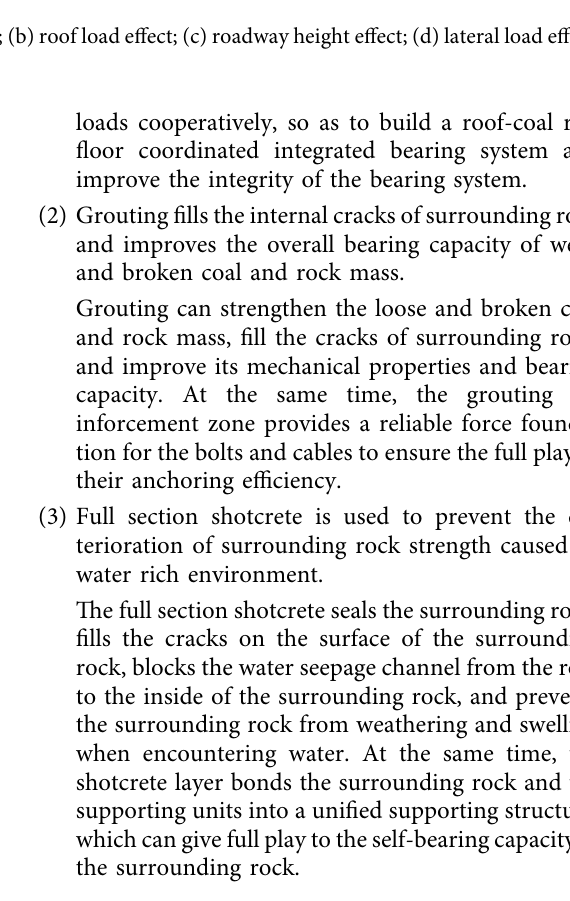
Figure 13. Specifc support parameters are as follows: